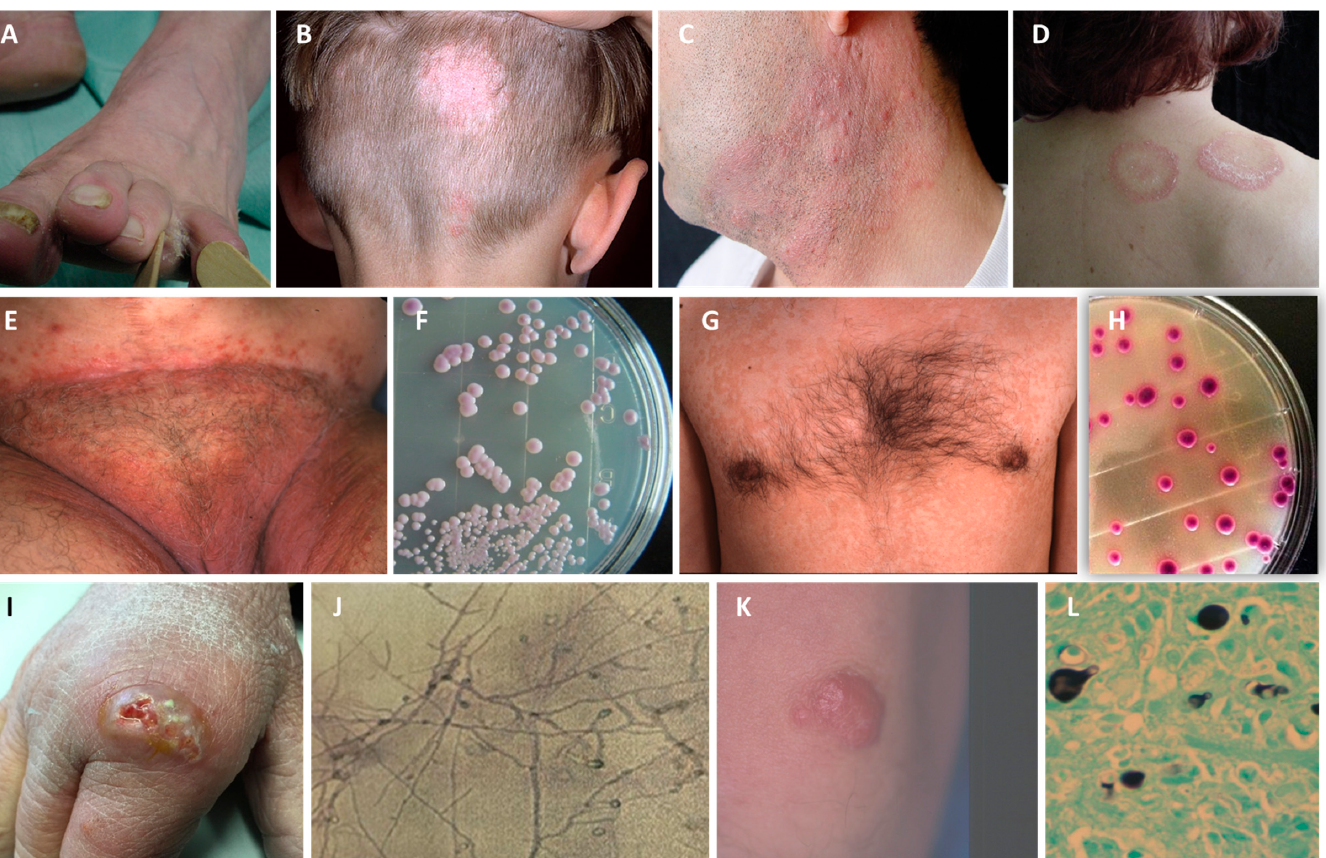
Figure 2. Clinical presentations and diagnosis of superficial and subcutaneous fungal infections ( A ): tinea pedis and onycomycosis; ( B ): tinea capitis ; ( C ): tinea barbae ; ( D ): tinea corporis ; ( E ): candidiasis; ( F ). Candida isolate grown on CHROMagar; ( G ). Pityriasis versicolor ; ( H ). Malassezia isolate on CHROMagar; ( I ): Subcutaneous fungal abscess in a renal transplant recipient; ( J ). Scedosporium apiospermum lactophenol cotton blue preparation showing conidia and septate hyphae; ( K ). Subcutaneous alternariosis in a renal transplant recipient with pulmonary Alternaria infection; ( L ): Alternaria spp. in tissue showing pigmented conidia (Gomori methenamine silver stain).